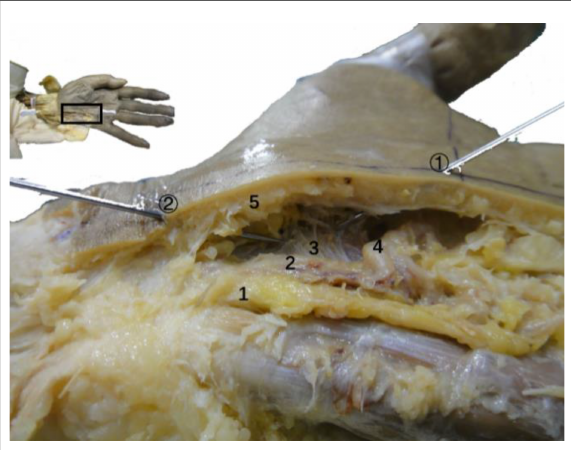
FIGURE 10 The longitudinal section of the needle-knife release technique guided by ultrasound. 1, ulnar nerve; 2, ulnar artery; 3, transverse carpal ligament; 4, super fi cial palmar arch; 5, palmar aponeurosis (section); ① , needle entry point 1; ② , needle entry point